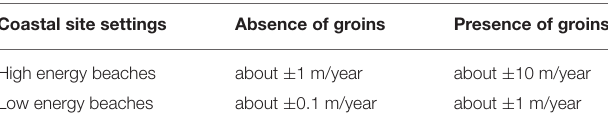
TABLE 2 | Order of magnitude for the annual longshore sedimentary processes contributions to shoreline changes for typical coastal settings in the Netherlands and Australia and for a closure depth of 10m (data from Stive,